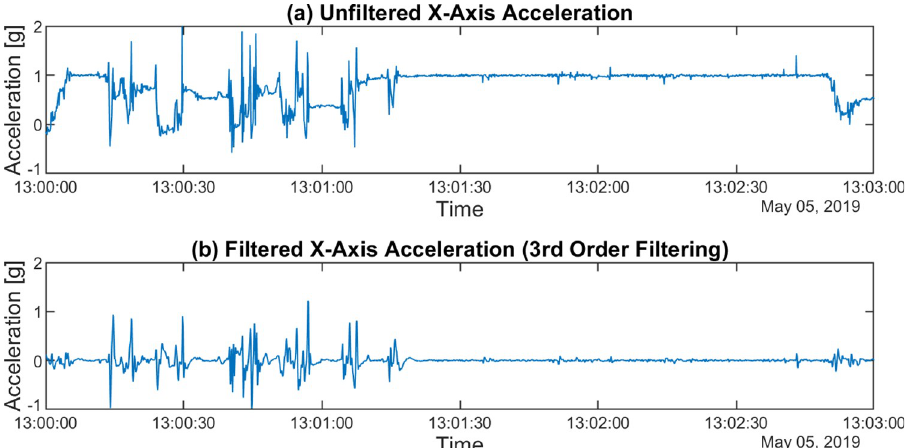
Fig 2. The effect of different filtering methods. The x-axis acceleration (a) was filtered using a 3rd order (b) digital Butterworth bandpass filter with fL = 0.25 Hz, fH = 2.5 Hz corner frequencies. The waveforms cover the same 3-minute-long section of a subject’s